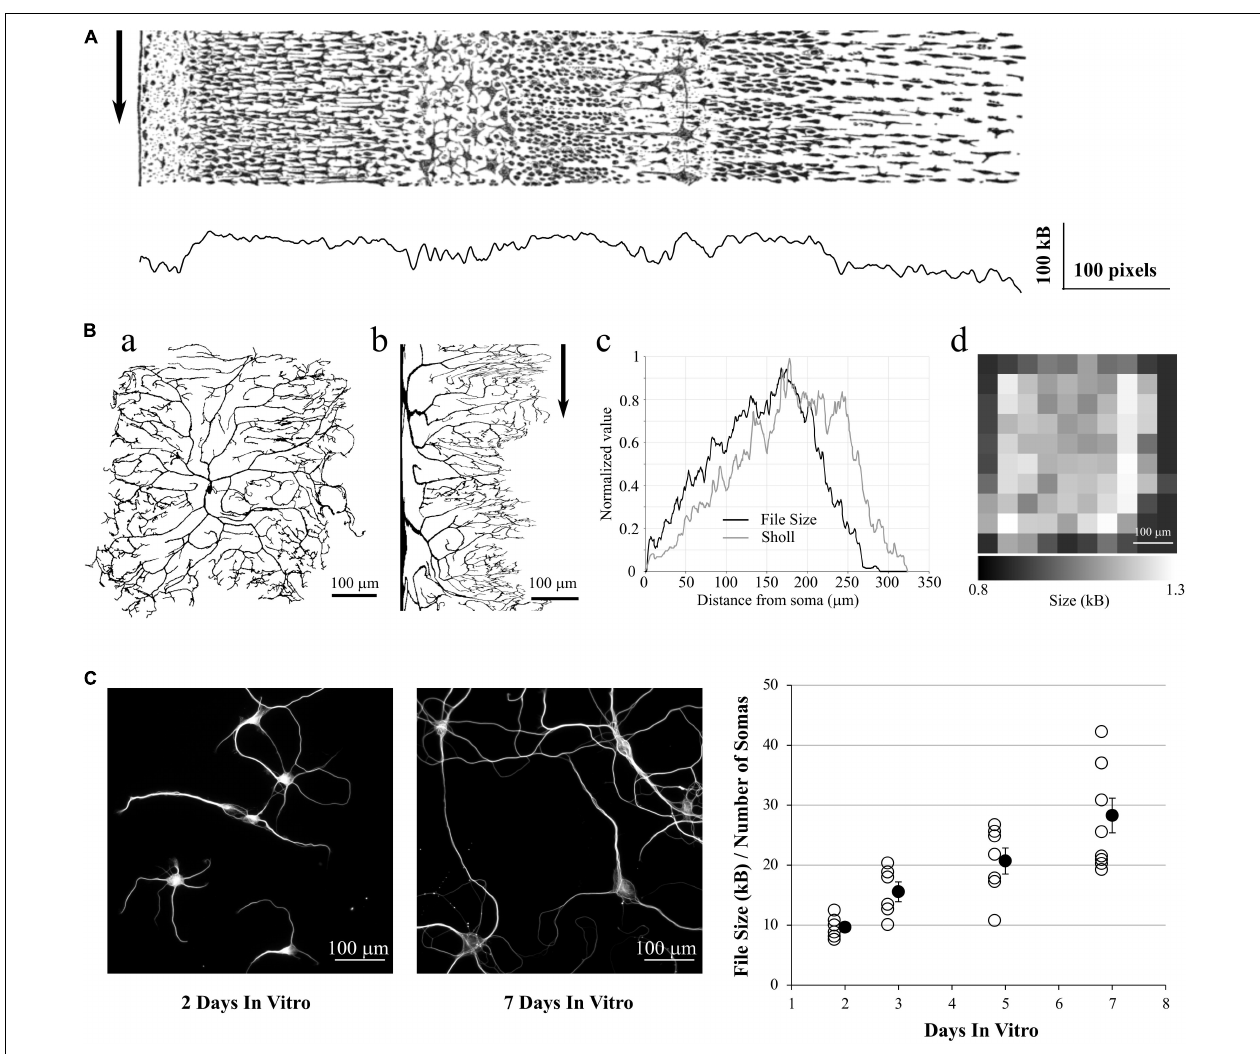
FIGURE 6 | Application to 2D data. (A) a: ddAC Neuron from Fiji examples. b: The same neuron after a circular anamorphosis centered on the soma. Note how the complexity of the dendritic arbor changes versus distance from soma. Arrow: each column of pixel was saved as a single PNG file. c: file size of these columns as PNG, showing the growth in complexity of the dendritic arborization (black line). As a comparison, we performed a Sholl analysis of the same image with default FIJI parameters (gray line). d: the original image was tiled in 10 squares, and each square saved as a PNG file. The sizes of these files reveal the heterogeneity of the dendritic arborization. (B) Left and Middle: examples of MAP2 stainings of Brandner and Withers neuronal cultures at 2 and 7 Days in vitro . Note the growth in dendritic arborization through time. Right: Each image was saved into a PNG file, and the file size divided by the number of visible somas. This gives us a file size normalized by the density of the culture. This value increases with the number of Days in-vitro , revealing the dendrite